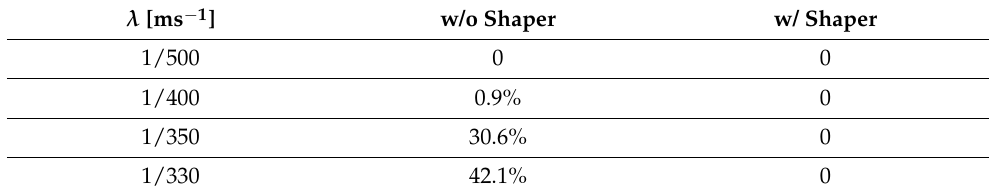
Figure 2. Service delay CDF of the sample scenario. Table 2. Service